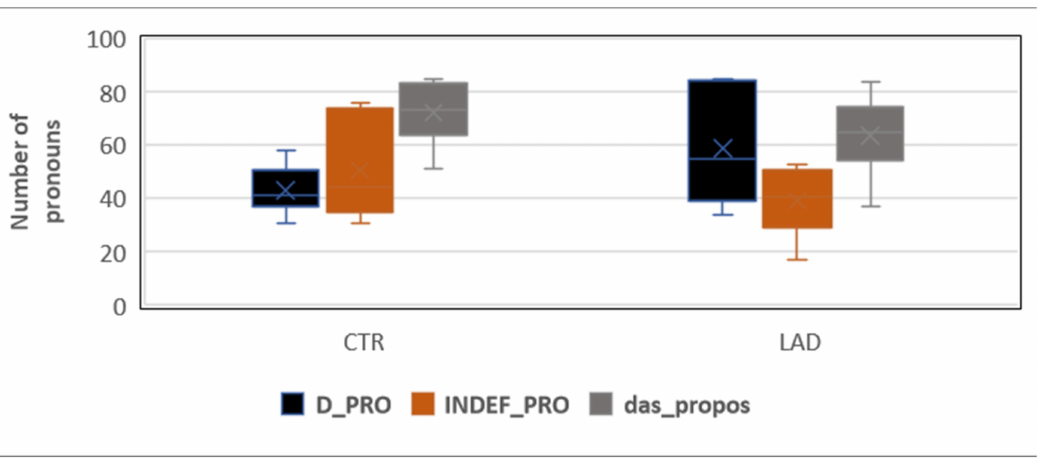
Figure 3. Range of proportions of D-pronoun (D_PRO), indefinite pronoun (INDEF_PRO), and proposi- tional das (das_propos) in the CTR group and the LAD